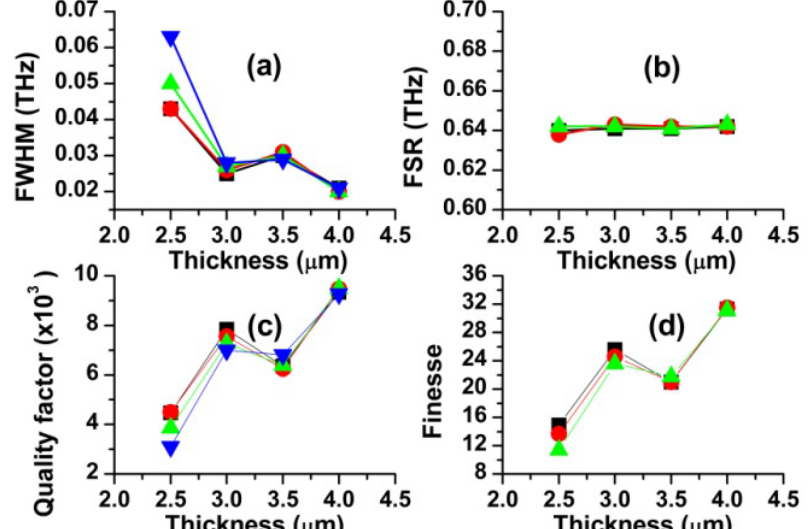
Figure 6. Effects of the ring thickness on the resonance characteristics (d = 100 μ m, w = 2 μ m, g = 0 μ m). Displayed four data sets are obtained from adjacent resonance peaks,